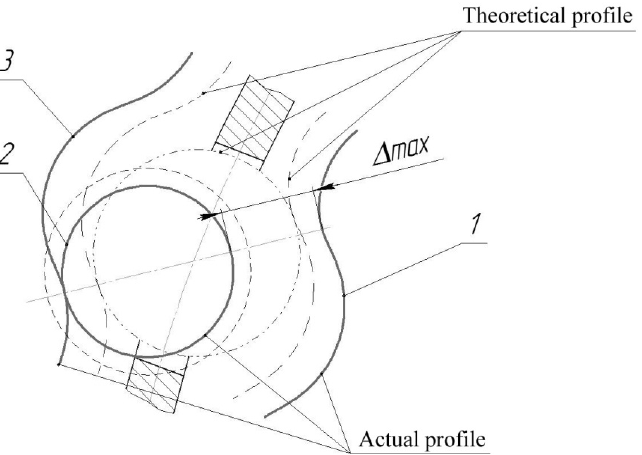
Figure 4. Diagram of the link position in the cycloid tooth system of a transmission with IREFC when manufactured with the maximum possible clearance: 1—cam; 2—intermediate rolling elements; 3—ring.